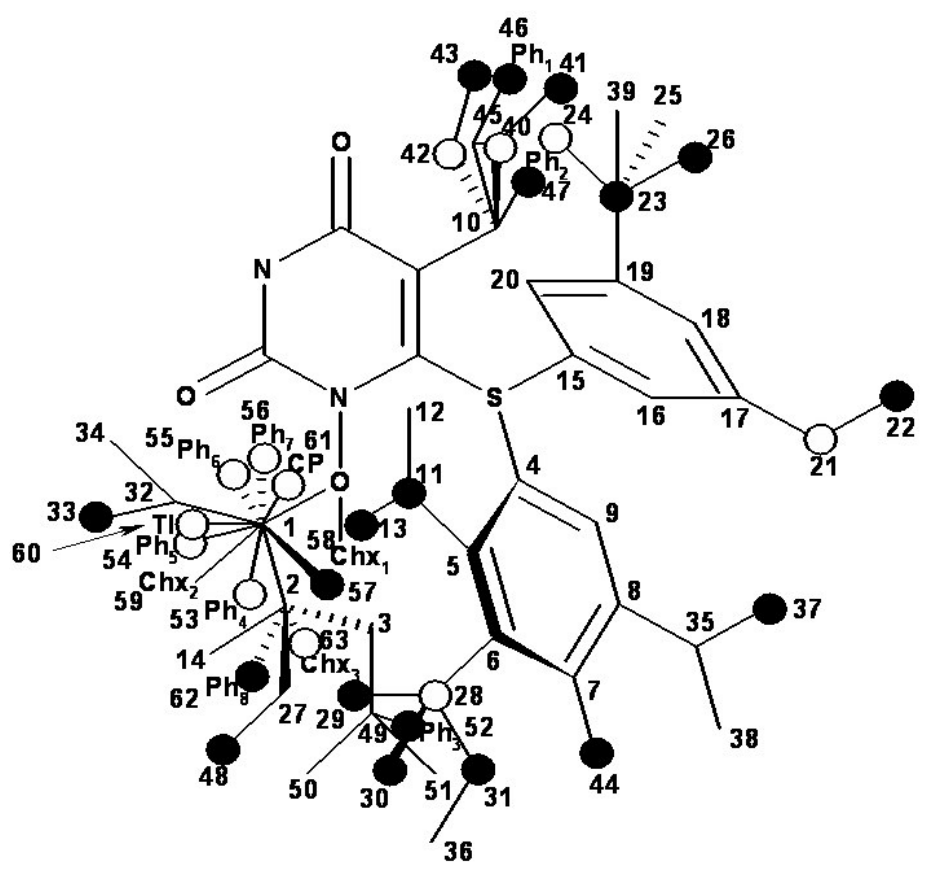
Figure 6. The occupancy of the hypermolecule vertices within the linear mono-parametric MTD model given by equation (12) and the optimized chart